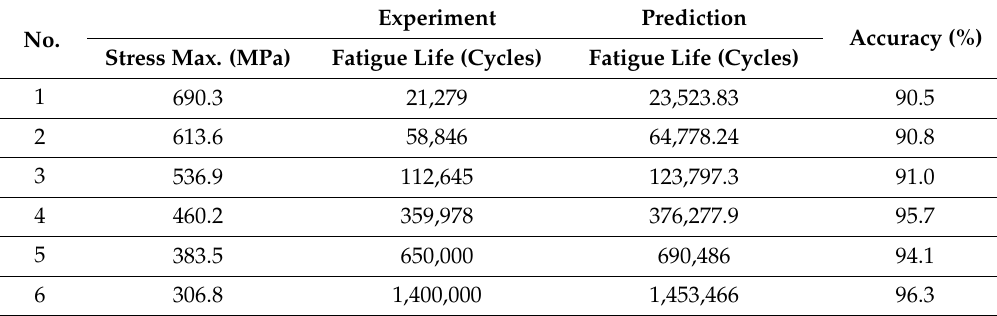
Table 5. Results of fatigue life prediction.